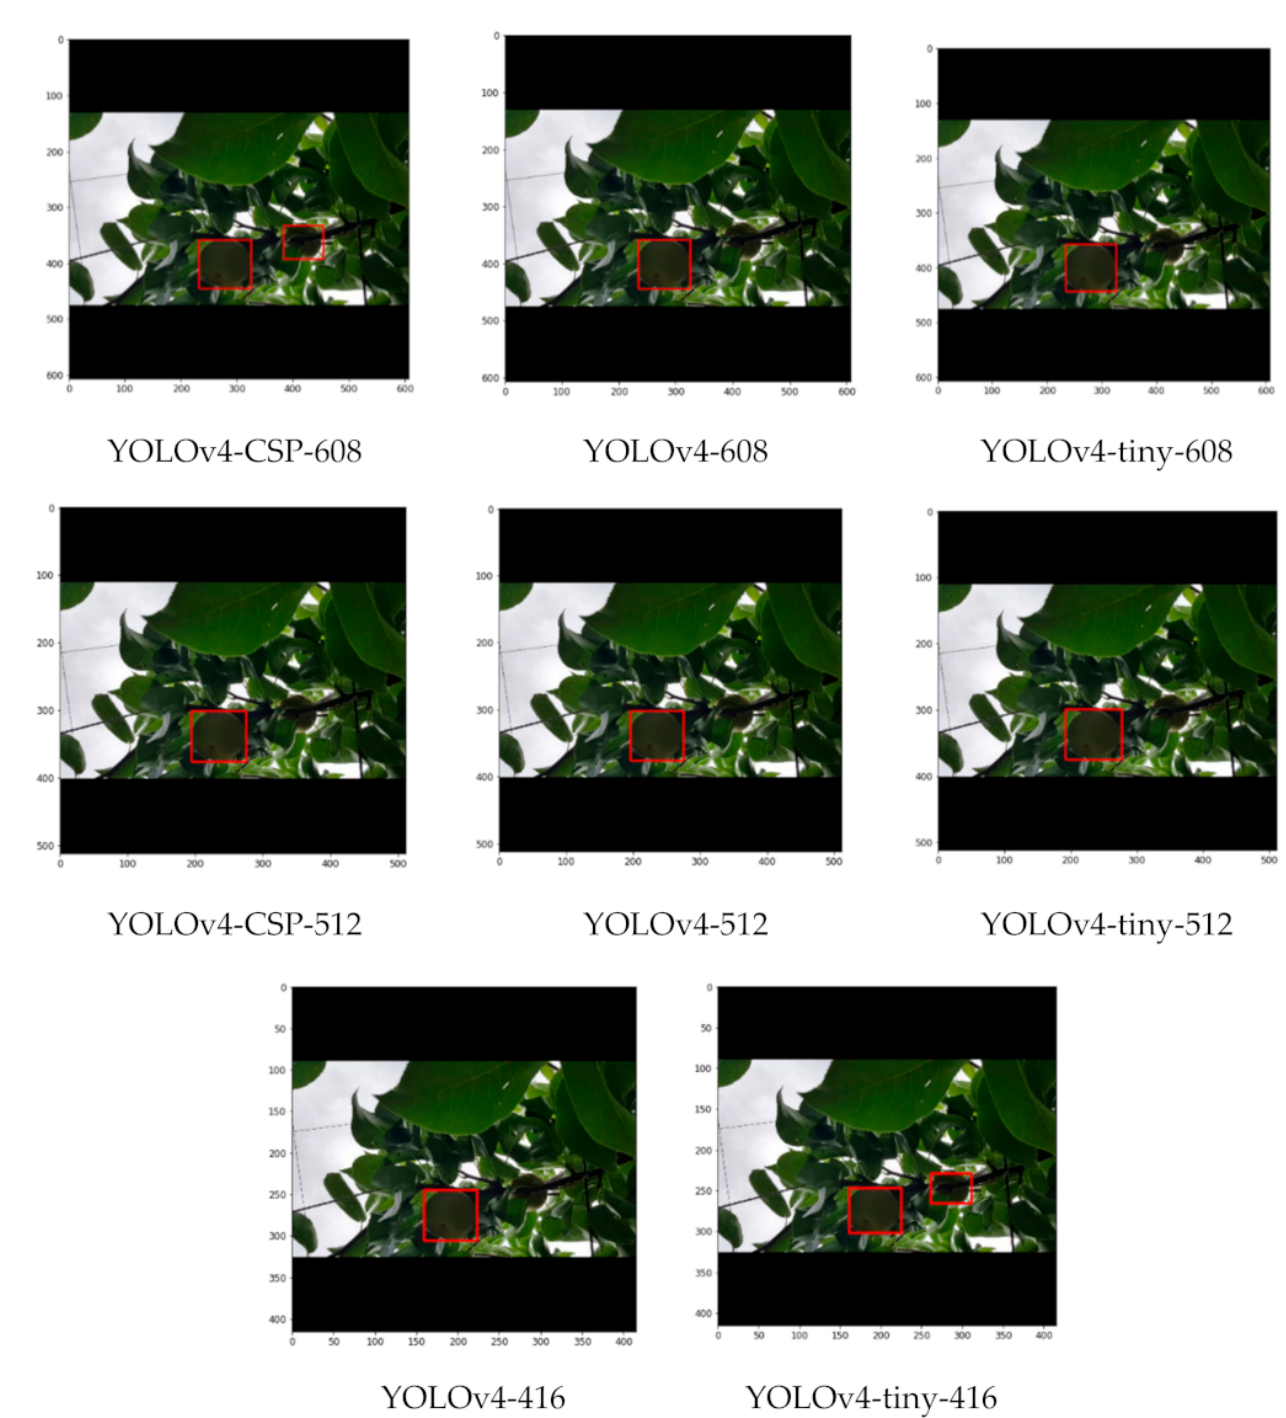
Figure 20. Example detections from the different YOLOv4 models using an image with moderate degree of occlusion and potentially challenging